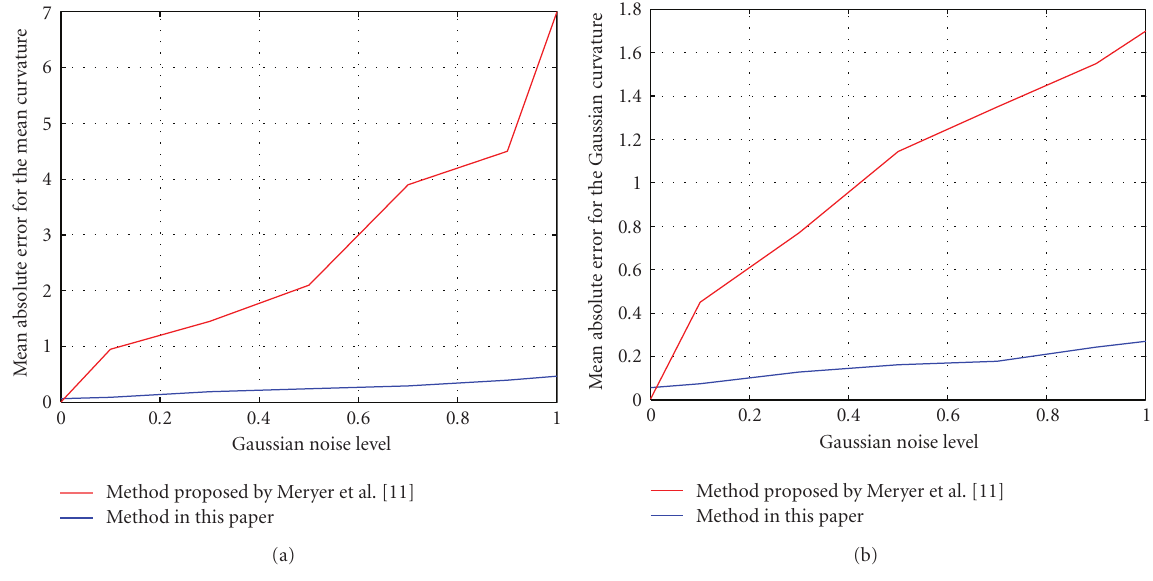
Figure 4: Average absolute error comparison. (a) Mean curvature. (b) Gaussian curvature.